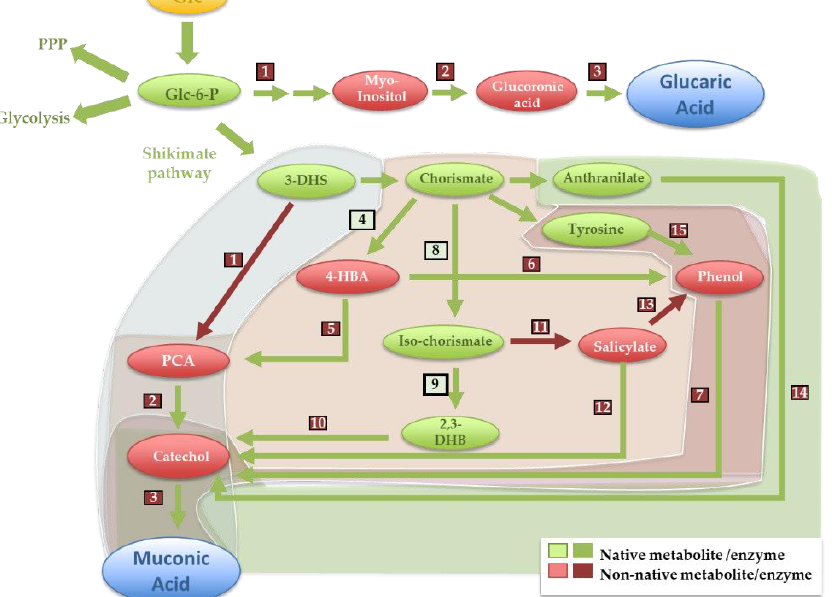
Figure 2. Muconic acid (MA) and glucaric acid (GA) assembled synthetic pathways. Each step is numbered according to the enzyme numbers indicated in Supplementary Table S1. The GA production pathway starts from Glc-6-P and involves the “exogenous” enzymes myo-inositol-1- P synthase (1), myo-inositol oxygenase (2) and uronate dehydrogenase (3). The MA production pathways start from 3-DHS, chorismate, anthranilate or tyrosine. The pathway starting from DHS involves a DHS hydratase (1), a protocatechuate decarboxylase (2) and a catechol 1,2-dioxygenase (3). Five different MA-production pathways originate in chorismate: (i) via 4-HBA, using a chorismate pyruvate lyase (4), a 4-HBA hydrolase (5), a protocatechuate decarboxylase (2) and a catechol 1,2- dioxygenase (3); (ii) via 4-HBA and phenol, using a 4-HBA decarboxylase (6), a phenol hydrolase (7) and a catechol 1,2-dioxygenase (3); (iii) via salicylate, using an isochorismate synthase (8), an isochorismate pyruvate lyase (11), a salicylate monooxygenase (12) and a catechol 1,2-dioxygenase (3); (iv) via salicylate and phenol, using an isochorismate synthase, an isochorismate pyruvate lyase, a salicylate decarboxylase (13) and a phenol hydrolase; (v) via tyrosine, using a tyrosine phenol lyase (15), a phenol hydrolase (7) and a catechol 1,2-dioxygenase (3). The pathway starting from anthranilate (a chorismate derivative) involves an anthranilate 1,2-dioxygenase (14) and a catechol 1,2- dioxygenase. G6P-glucose-6-Phosphate; 3-DHS -3-dehydroshikimate;